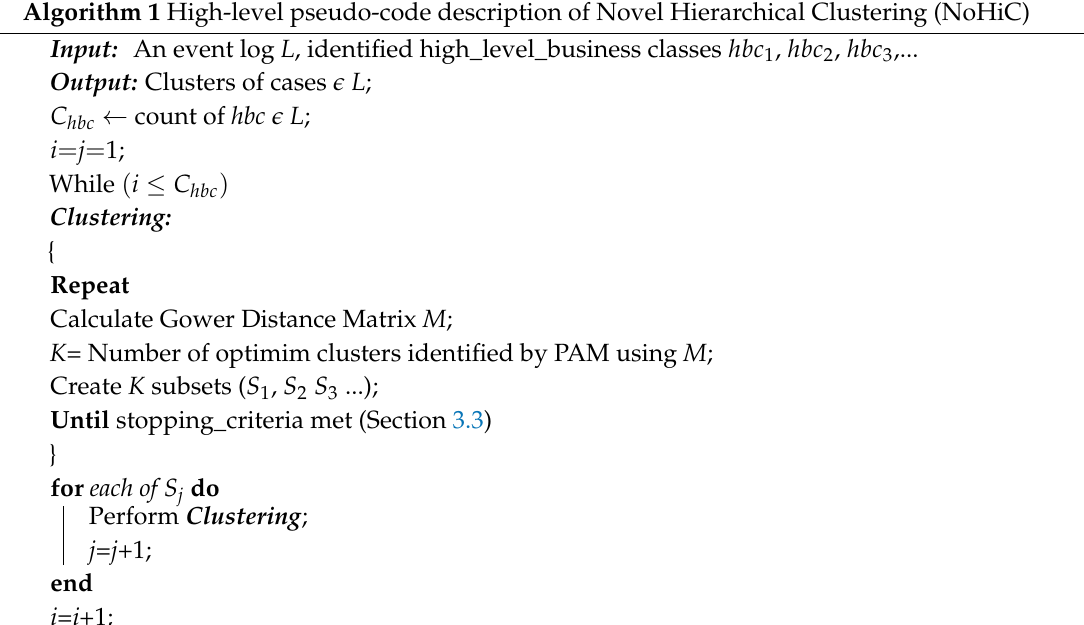
Algorithm 1 High-level pseudo-code description of Novel Hierarchical Clustering (NoHiC)